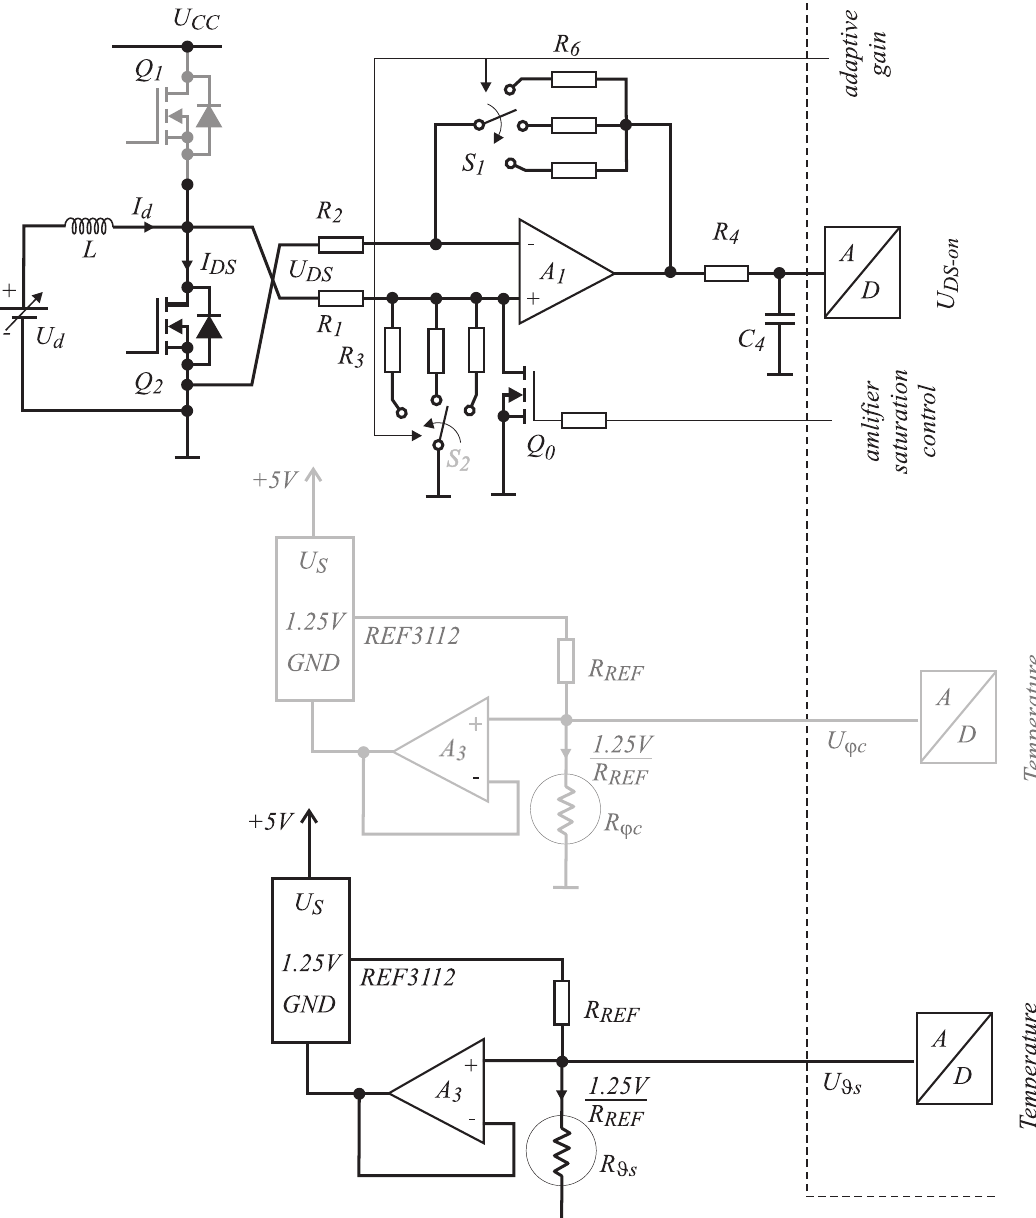
measurement and the temperature DS